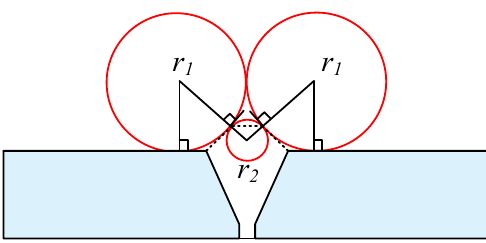
Figure 4. Three-tangent-circle geometric optimization methods.